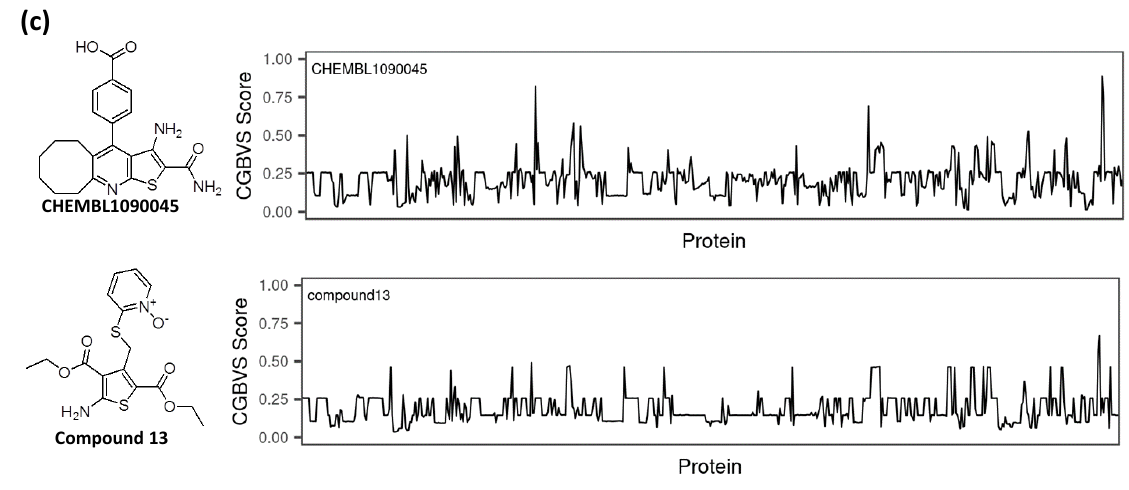
Figure 5. Comparison of CGBFP profiles between hit compound and its most similar (nearest neighbor) compound. The x-axis is represented by 599 CGBVS target proteins, and the y-axis indicates CGBVS score (binding probability score). CGBSP score is determined by calculating the cosine similarity between CGBFP of the hit compound and its most similar compound. Morgan fingerprint similarity is calculated by Tanimoto coefficient [40] between Morgan fingerprints of a compound and its most similar compound. The Morgan fingerprints were calculated with a radius of r = 2 and 2048 bit length using RDKit. ( a ) CHEMBL1089330 vs. Compound 2, ( b ) CHEMBL1090045 vs. Compound 4. ( c ) CHEMBL1090045 vs. Compound